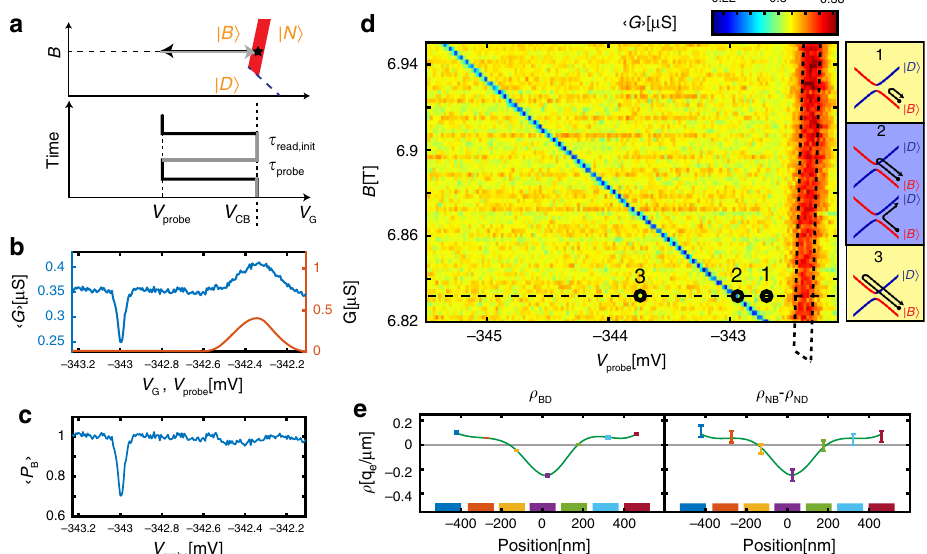
Fig. 4 Time domain measurements of the qubit transition. a Measurement sequence, plotted in gate voltage – B || plane (top) and in gate-voltage time diagram (bottom). The state is initialized on the N j i ↔ B j i Coulomb blockade (CB) line (red, star marks initialization point). Voltage on the center three gates is rapidly ramped to a value V probe , dwelling a time τ probe , and then ramped back to the original point on the CB line, dwelling a time τ read,init . The sequence is repeated periodically. b Conductance averaged over the above sequence, G h i , measured as a function of V probe (blue) and the quasi-DC conductance, G (red), measured at the same point in V G . c Bright state return probability, P B h i as a function of V probe , determined from G h i and G in panel b (see text). d Similar measurement of G h i but now as a function of V probe and B || . A red peak is visible at the location of the Coulomb blockade peak and a much narrower blue dip appears along a line that corresponds to the D j i ↔ B j i crossing. Both a fast traverse to a point before this line (marked 1) or after this line (marked 3) do not alter the state of the system from its initialized B j i state, however, a fast traverse to a point on the line (marked 2) results in occupation of the D j i state with a signi fi cant probability. The corresponding traverses in energy are shown in the side panels. e Left: The change in spatial charge distribution at the D j i ↔ B j i transition, ρ BD ( x ), imaged using gate resolved capacitance shift imaging of this line (as outlined in Fig. 3a). Right: The difference between the the spatial charge distributions measured at the N j i ↔ B j i and N j i ↔ D j i transitions, ρ NB ( x ) − ρ ND ( x ), taken from Fig. 3c and d, strongly resembling the directly imaged ρ BD ( x ) in the left panel, further con fi rming that the narrow line corresponds to the D j i ↔ B j i